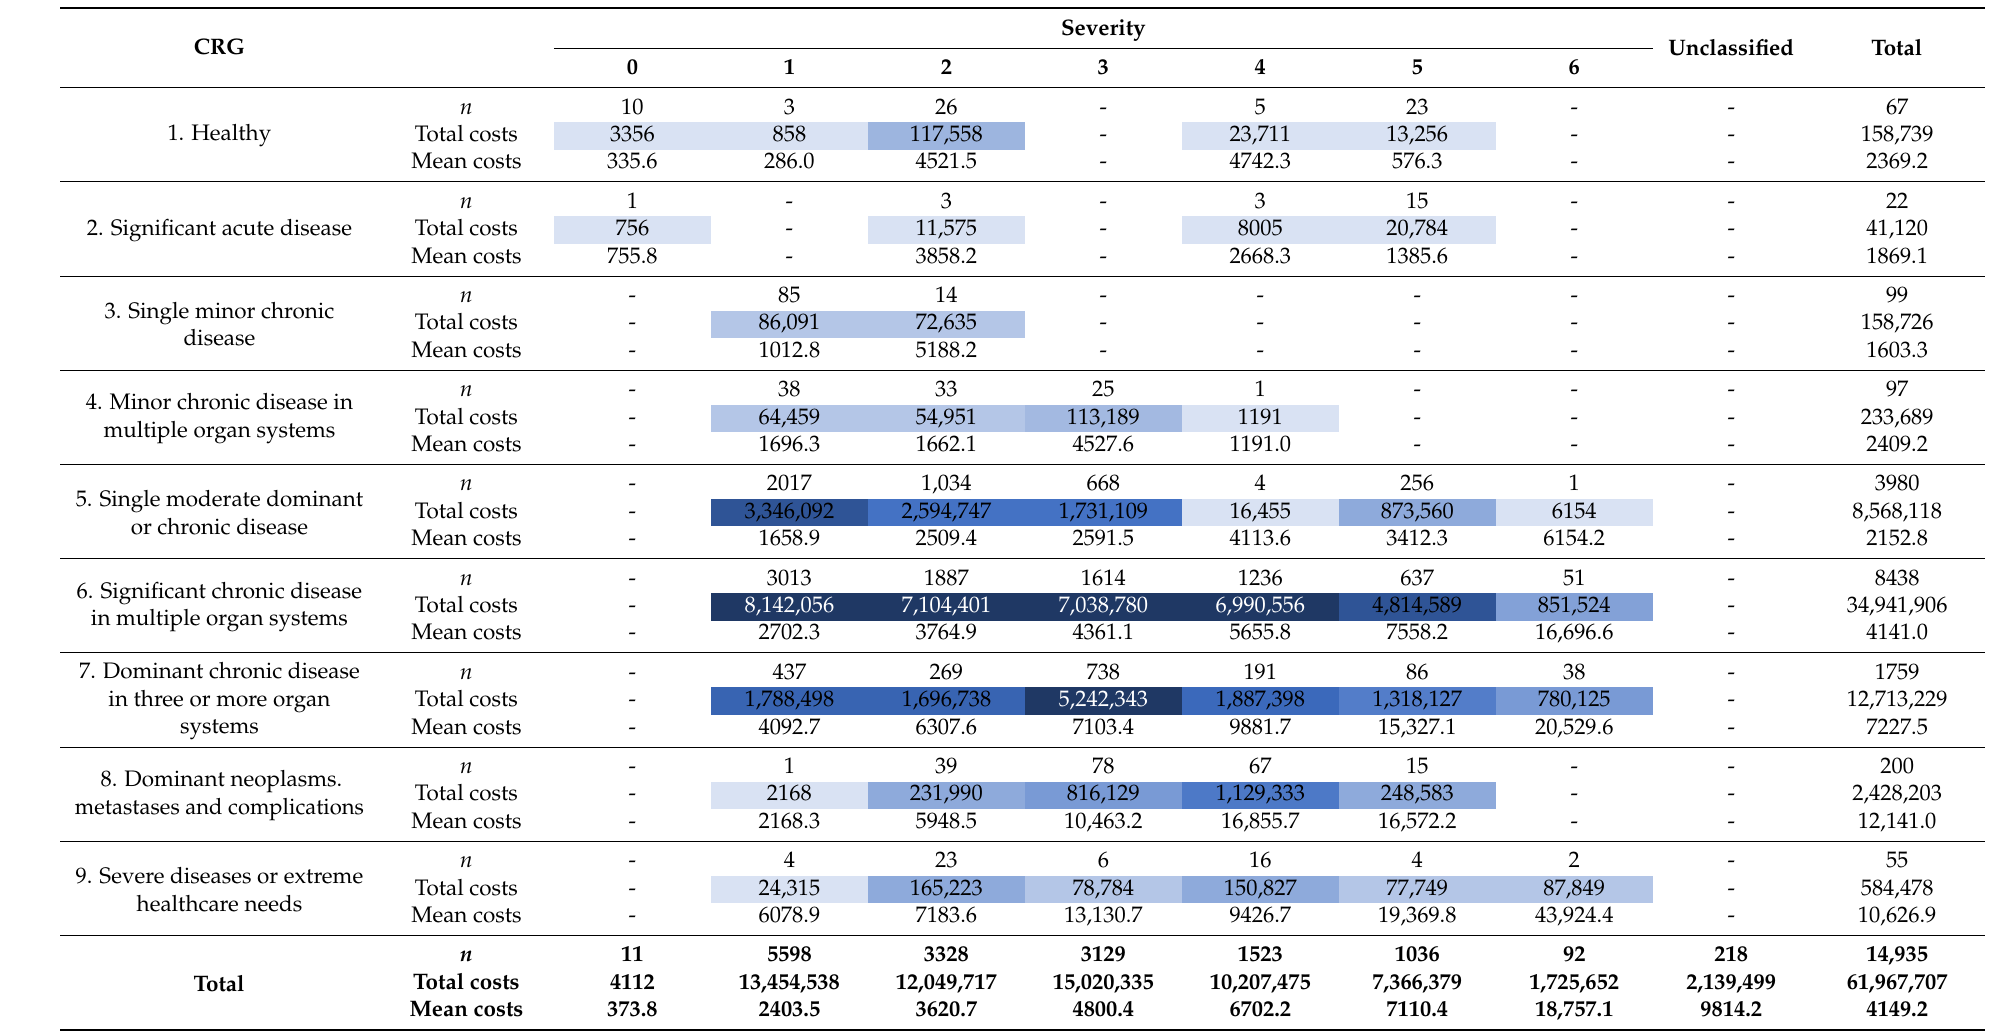
Table 6. Total and mean costs (EUR) according to CRGs ( n =